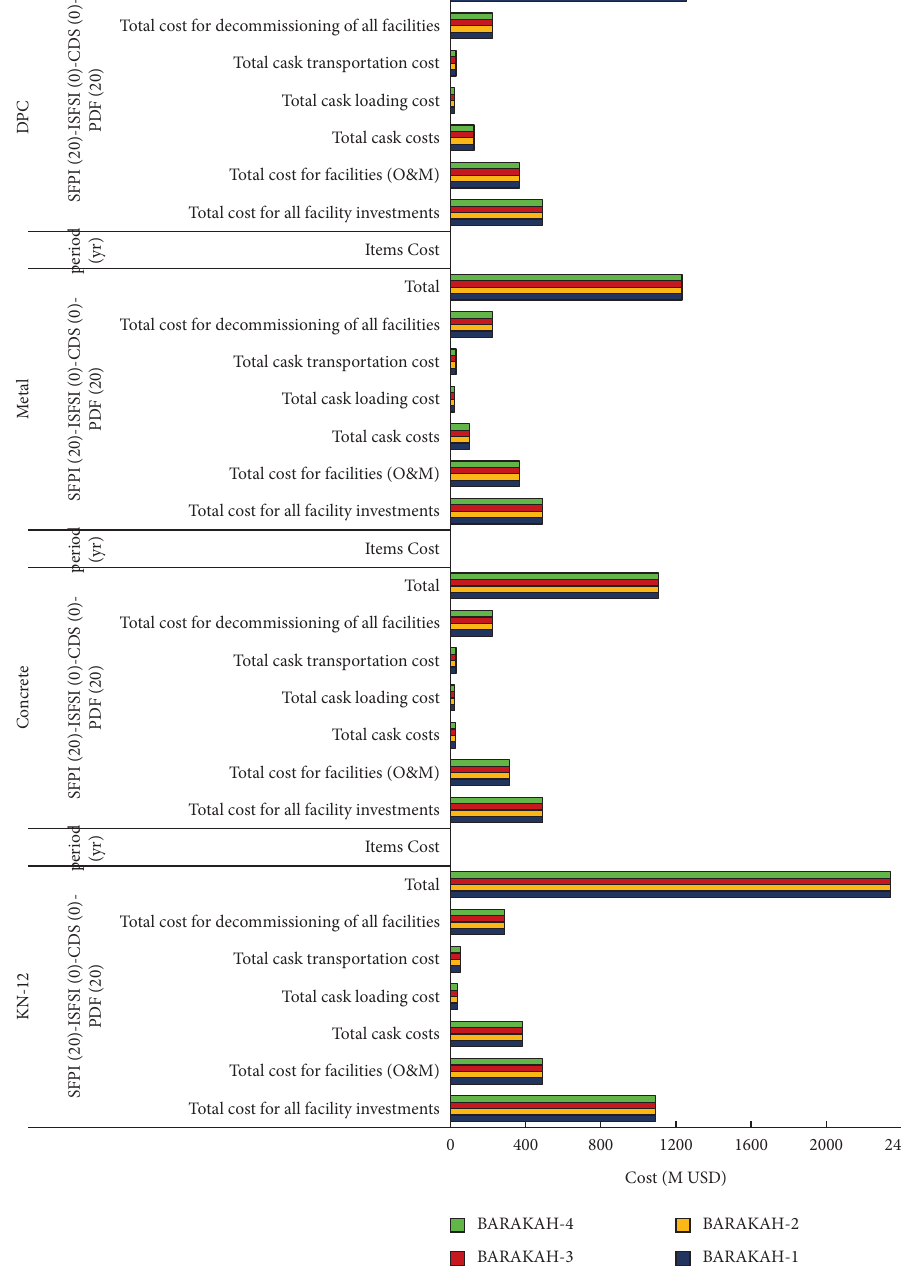
Figure 13: Total cost per cost category for different types of cask storage, for Sc-7 of Barakah